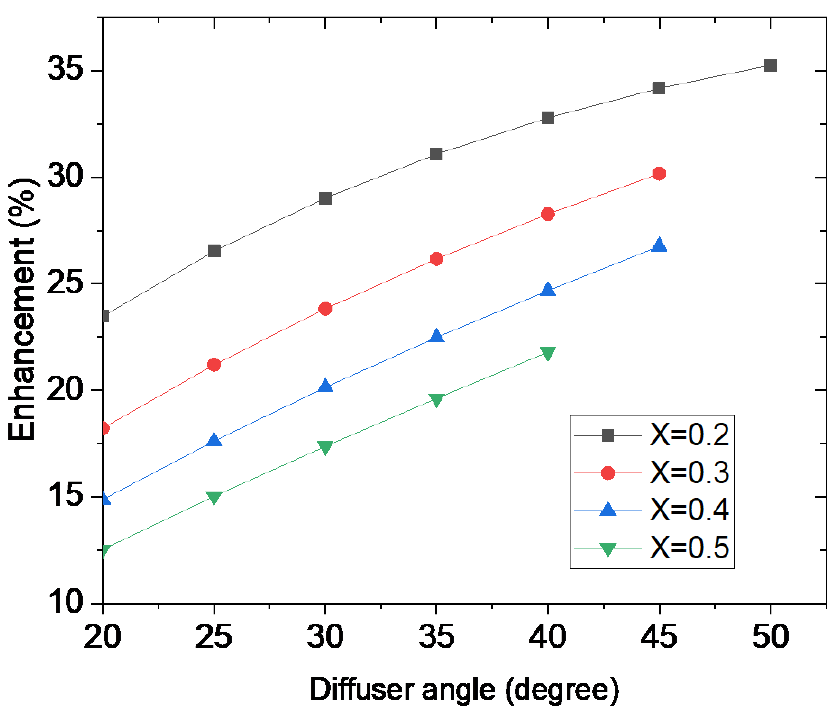
Figure 14. Performance enhancement evolution versus diffuser angle for multiple X.